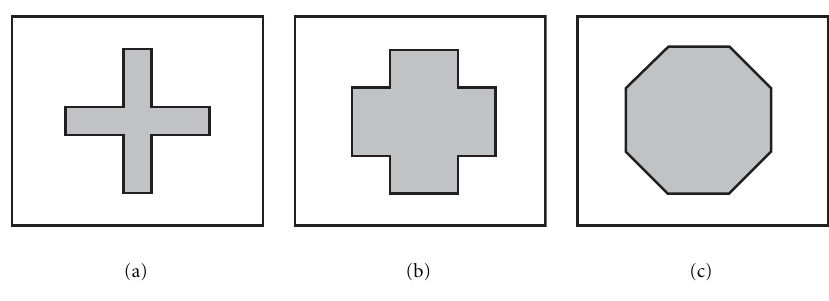
Figure 10: Illustration of region and contour